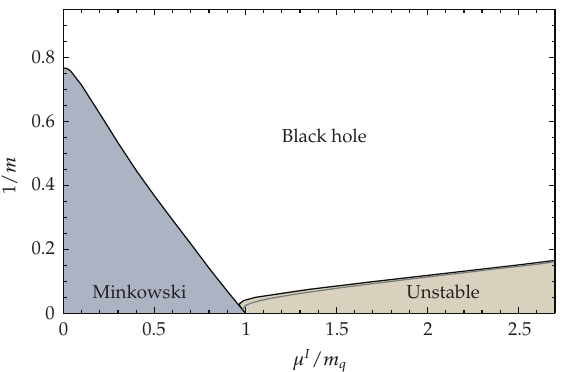
Figure 23: the (cid:2) μ I ,T (cid:3) -plane. In the blue-shaded region D7-branes have the topology of Minkowski embeddings, the white and brown regions are modeled by black hole embeddings. These become unstable in the brown region. The boundary of the unstable region asymptotically seems to agree with the thin gray (cid:11) line of constant density d I (cid:5) 20 .